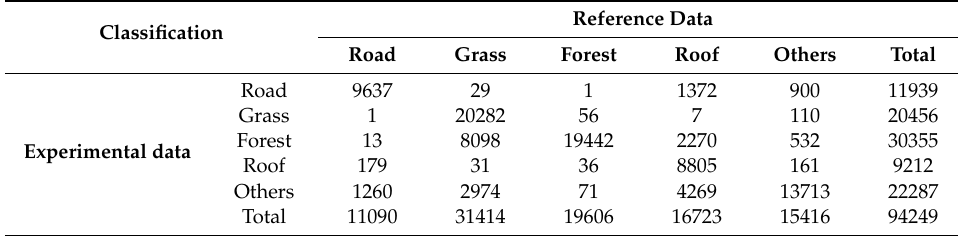
Figure 6. Sample points distributed in the studied region. Table 6. Accuracy assessment confusion matrix based on full inspection.